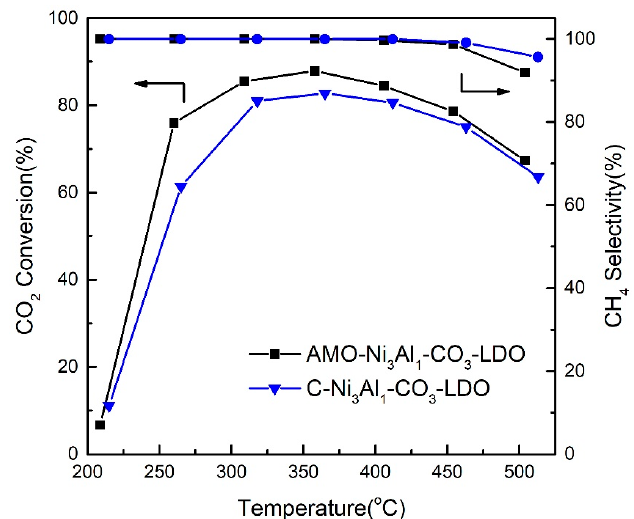
Figure 5. CO 2 conversion (%) and CH 4 selectivity (%) vs T profiles over AMO-Ni 3 Al 1 -CO 3 -LDO and C-Ni 3 Al 1 -CO 3 -LDO catalysts for the CO 2 methanation reaction.